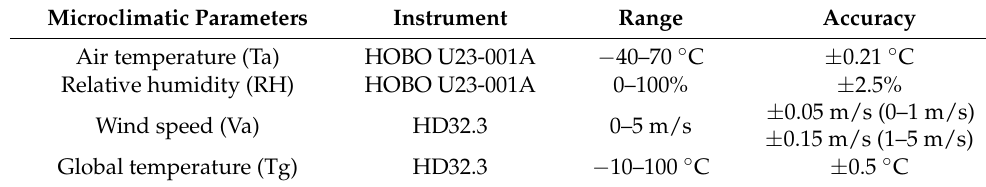
Table 2. Metrological properties of measuring instruments.